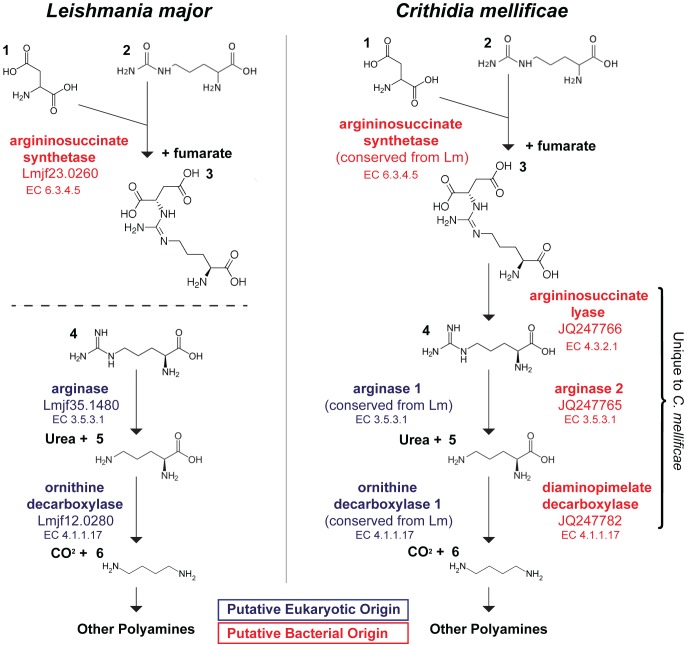
Urea and polyamine synthesis in trypanosomatids.The putative origin of genes involved in urea and polyamine synthesis is indicated by color; eukaryotic (blue) or bacterial (red) origin. For C. mellificae, genes conserved from L. major are displayed on the left column and unique genes on the right; the compounds are numbered as follows: 1. aspartic acid, 2. citrulline, 3. argininosuccinate, 4. arginine, 5. ornithine, 6. putrescine.